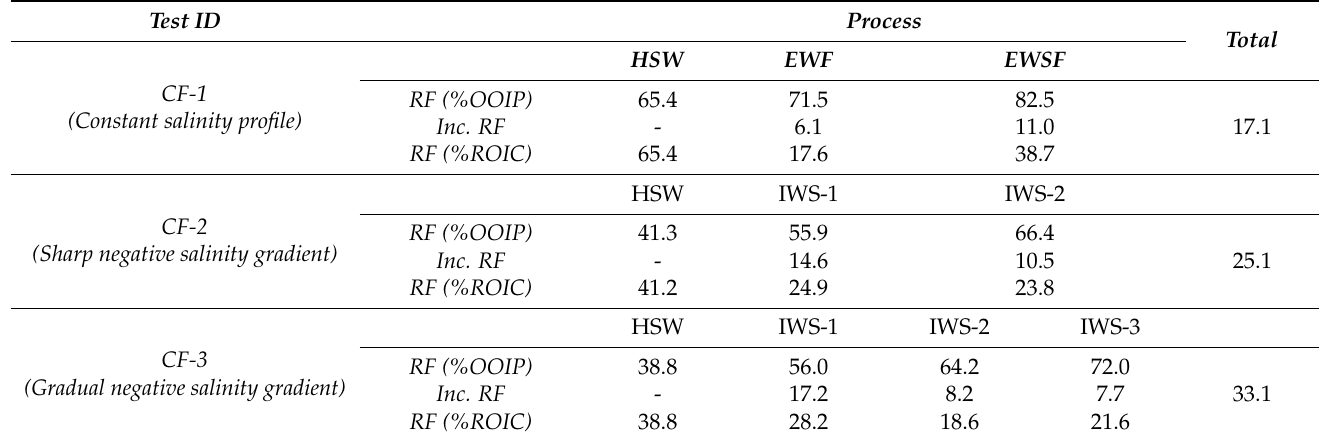
Table 6. Summary of oil recoveries obtained from CF-1, CF-2, and